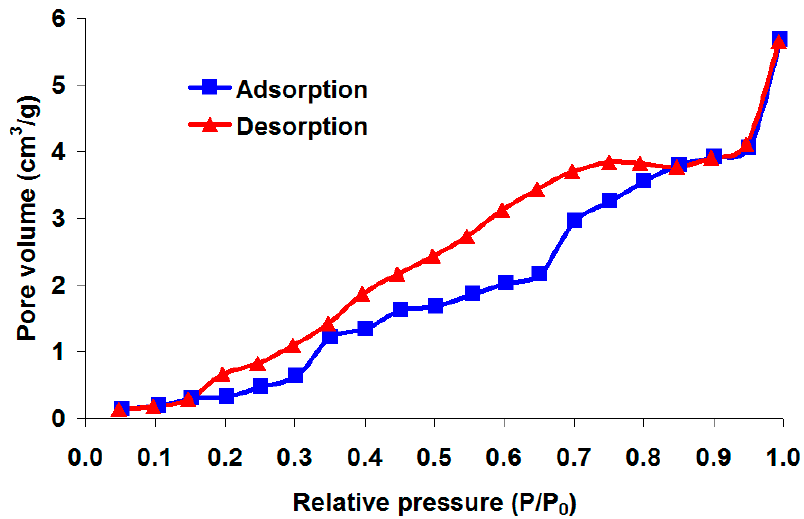
Figure 7. Nitrogen’s (N 2 ) physical adsorption–desorption isotherms of washcoat synthesized using aluminum dross and coal fly ash .